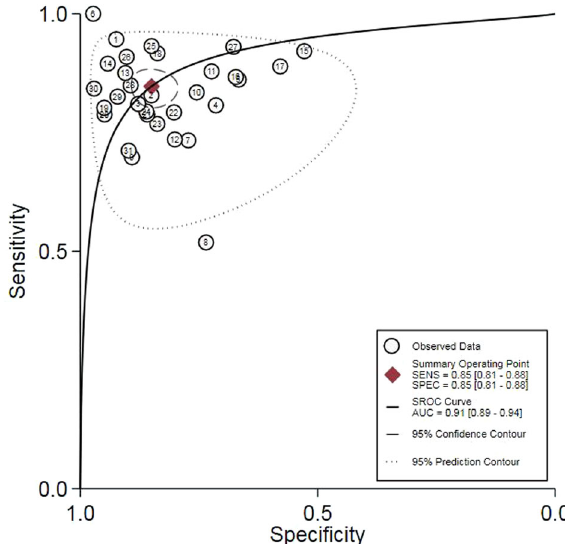
Fig. 6 Bivariate summary estimates of sensitivity and speci fi city, with corresponding 95% con fi dence ellipse around the mean values, for all studies. SENS sensitivity, SPEC speci fi city, SROC summary receiver operating characteristic, AUC area under the